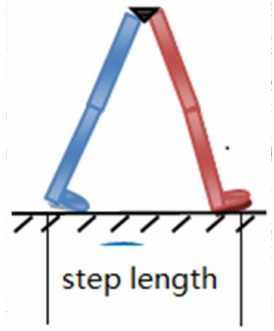
Figure 2. The illustration of the step length.